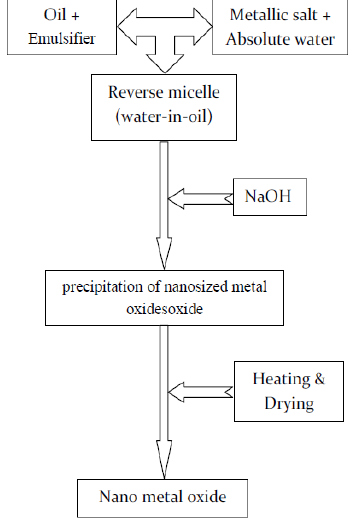
Fig. 1. Experimental procedure for the formation